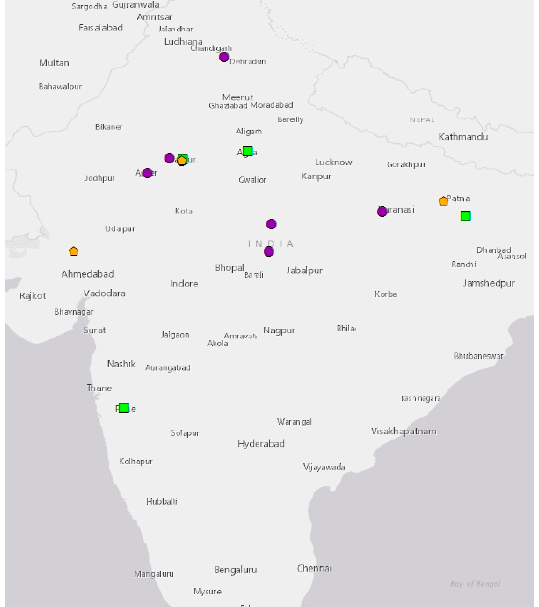
Figure 3. Places of preservation of Manohard ā s’ Dharmapar ī k ṣ ā .